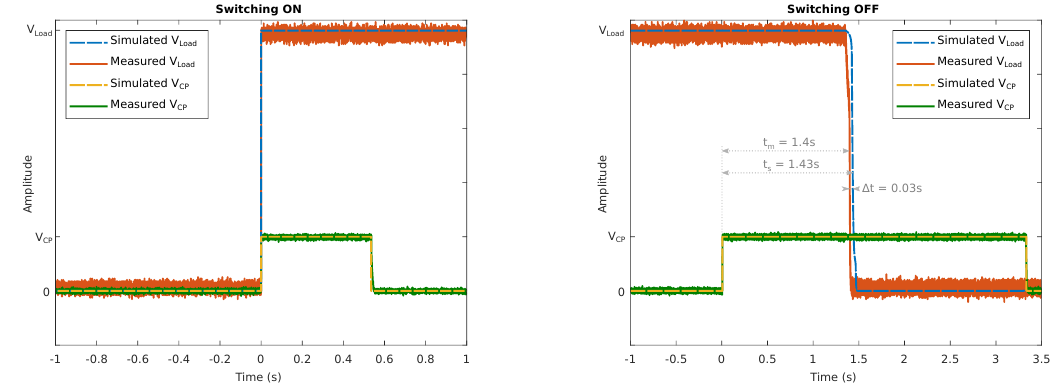
Figure 3. Simulation and measurement results of the switching process. When a voltage V CP is applied, the circuit reacts and the battery is connected or disconnected to the